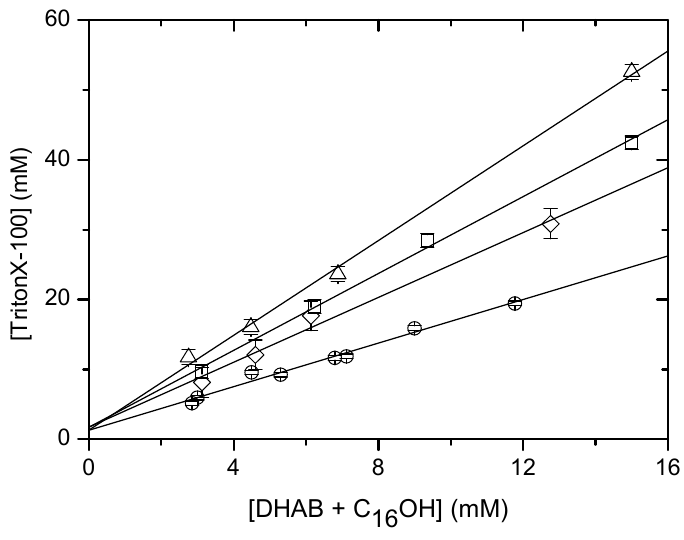
Figure 4B. R relationships between [TritonX-100] vs. [DHAB + C sol